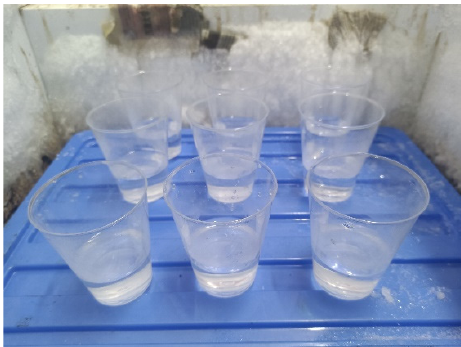
Figure 5. Ice ‐ melting ability test of the solution with gradient concentration. Figure 5. Ice-melting ability test of the solution with gradient